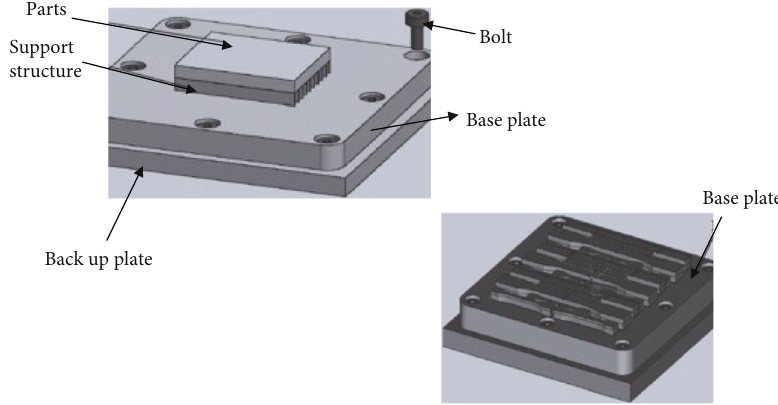
Figure 11: Schematic view of an example of a rigid base plate that can be used in low-temperature PLS